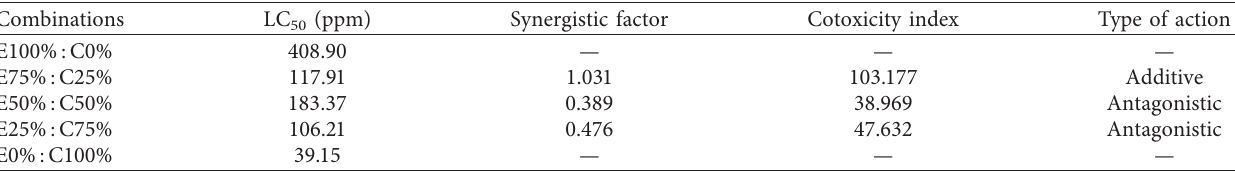
Table 4: Synergistic factor and cotoxicity index of the combination of the methanol extracts of E. camaldulensis and C. rigidus.